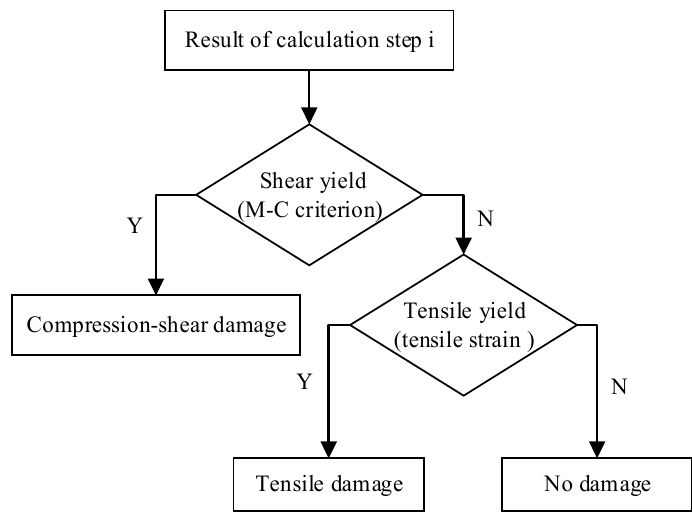
Figure 12. Evaluation process of damage deterioration of surrounding rock elements.